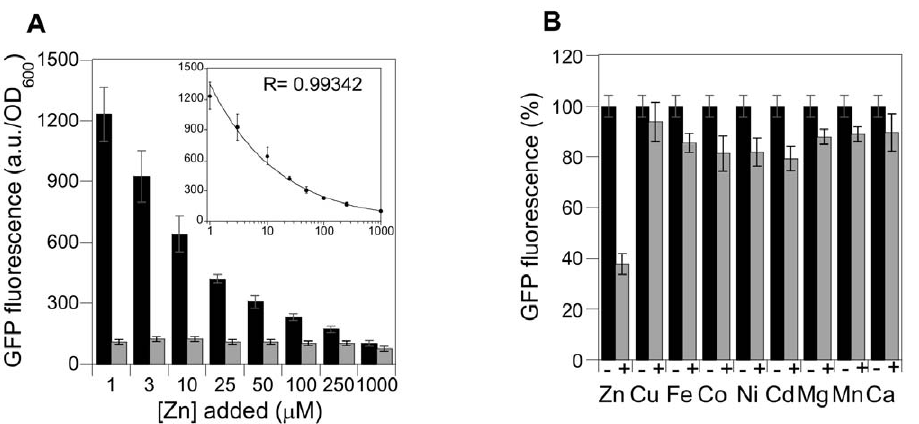
Figure 2. Zinc responsiveness of ZRE-GFP promoter-reporter construct. A) Comparison of Zn-dependent GFP fluorescence in untransformed yeast cells (gray bars) and yeast transformed with the ZRE-GFP promoter-reporter construct (black bars). Cells were grown in LZM medium with indicated zinc concentrations. GFP fluorescence and cell density were measured after 20 hours of incubation at 30 u C. The inset shows a power law fit through the data. The excellent quality of the fit (the linear correlation coefficient between the fluorescence and the zinc concentration to the power 2 0.372 is R=0.993) indicates that the fluorescence decreases with increasing zinc concentration in a scale-free manner. B) Metal specificity of the promoter-reporter construct. Transformed cells were grown in LZM either without (black bars) or with 100 m M (gray bars) of indicated metal ions and analyzed as before. GFP fluorescence is expressed as percent of non-supplemented control. The fluorescence signal was always normalized by cell density. Error bars represent standard deviation (SD).